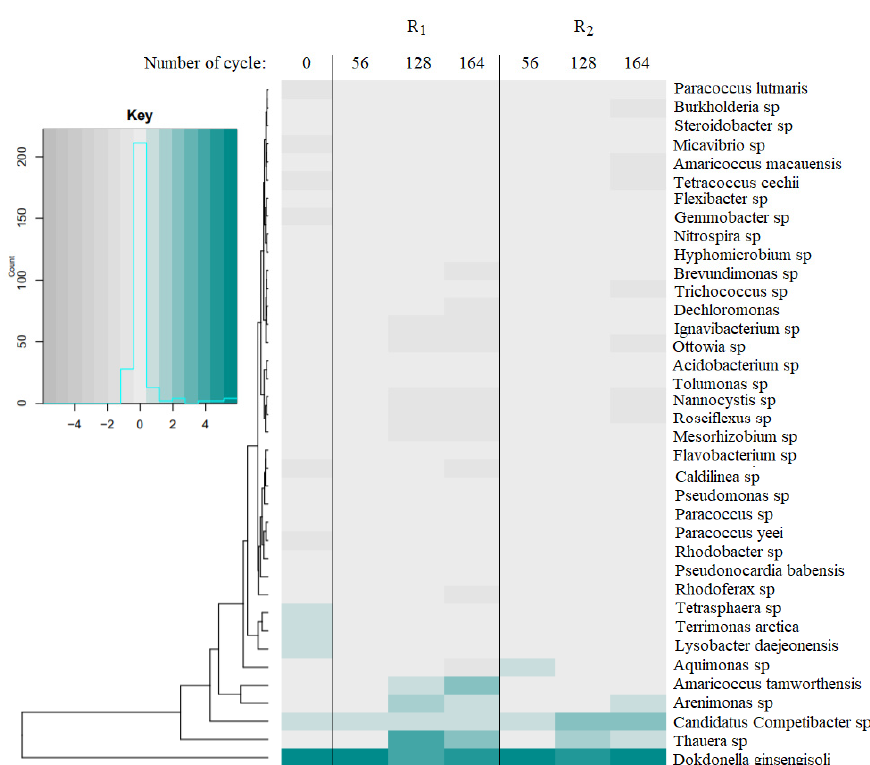
Figure 3. Heatmap of relative abundance of bacterial taxa present in aerobic granules (abundance higher that 0.5%).